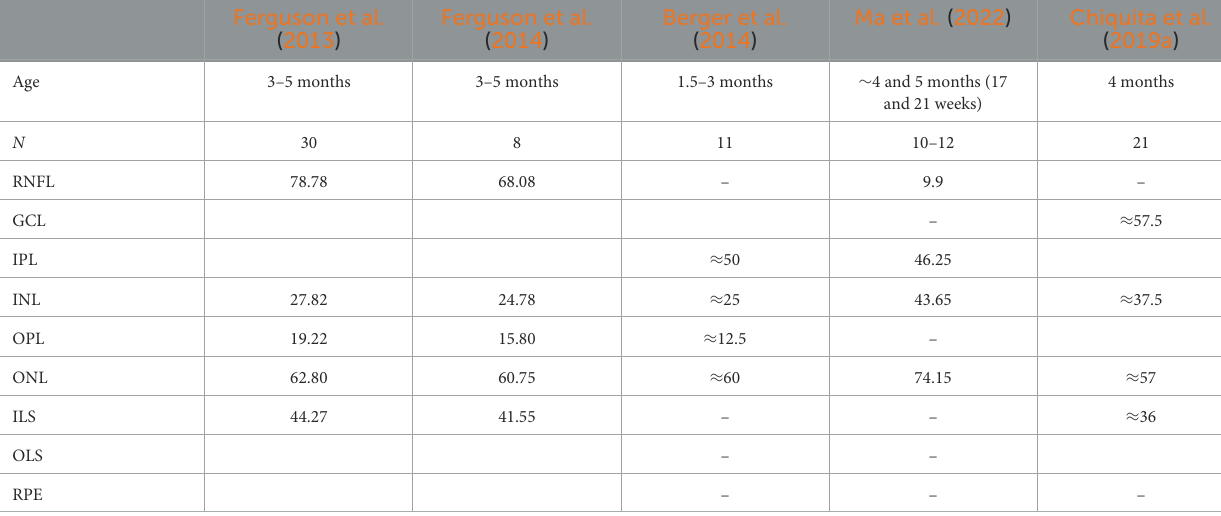
TABLE 4 Comparison of mean thickness of retinal layers/layer aggregates reported in the literature. Ferguson et al.